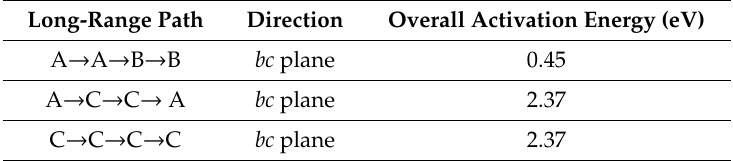
Table 3. Long-range Na ion diffusion paths and their overall activation energies.